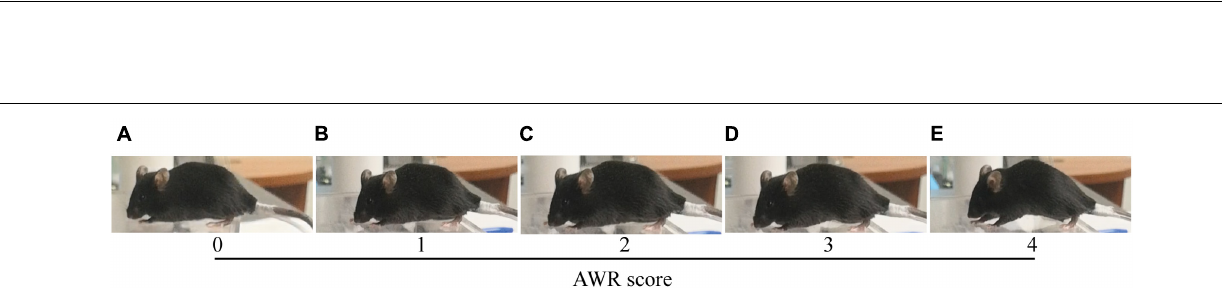
FIGURE 3 | AWR score based on mice behavioral response to CRD. (A) 0, no behavioral response to CRD; (B) 1, brief head movement followed by immobility; (C) 2, contraction of abdominal muscles; (D) 3, lifting of abdomen; (E) 4, body arching and lifting of pelvic structures (Gosselin et al., 2010). AWR, abdominal withdrawal reflex; CRD, colorectal